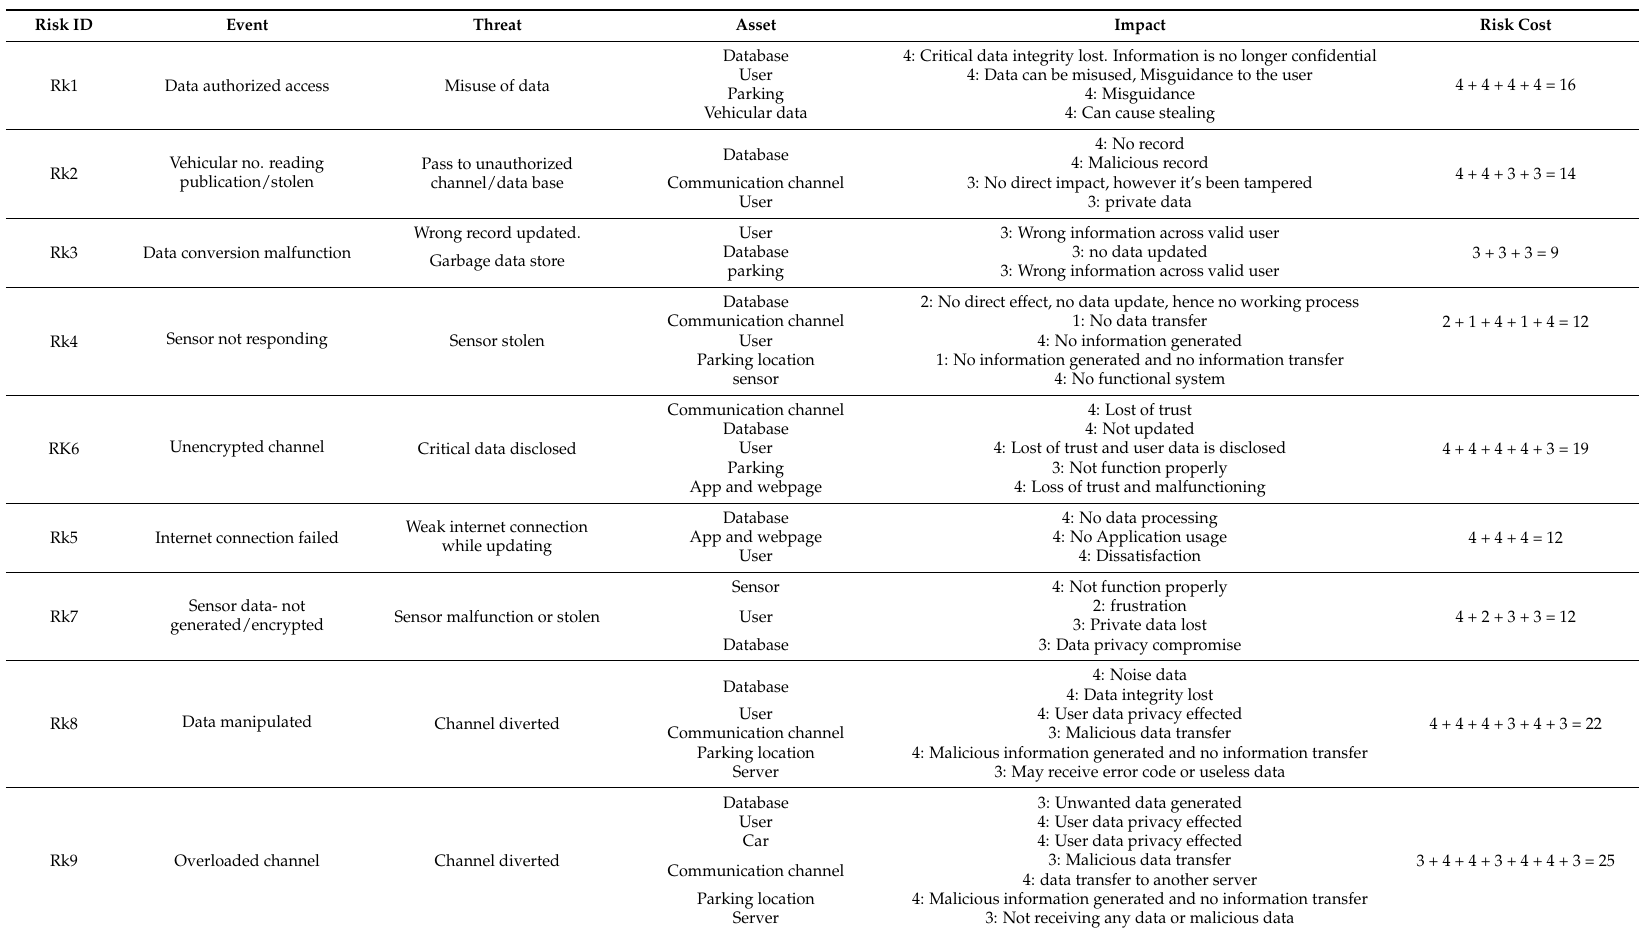
Table 2. Risk Cost